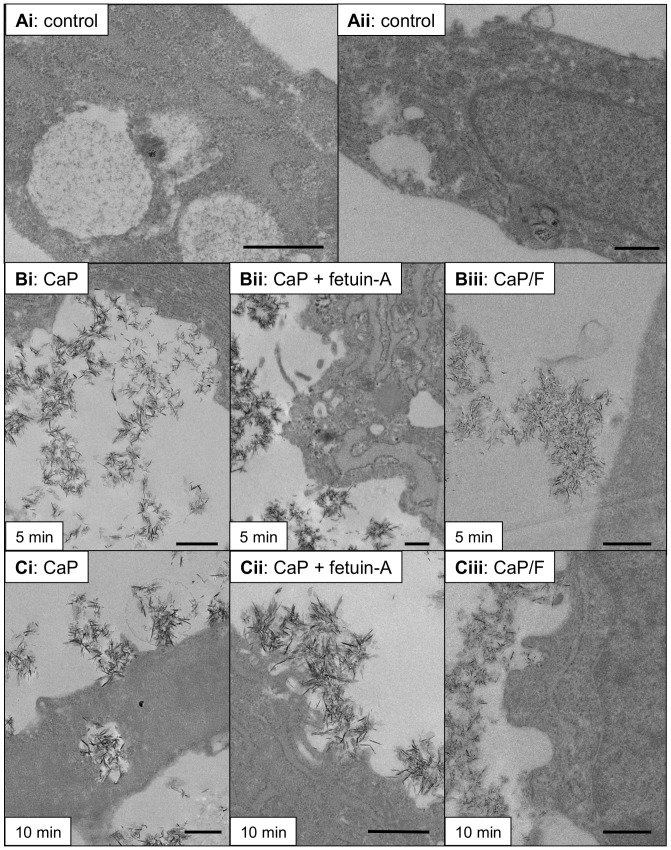
TEM images of CaP particle/VSMC interactions in the presence of fetuin-A.TEM images show ultrastructural features observed after treatment of VSMCs with CaP particles (12.5 µg/mL) ± fetuin-A (1 µM) or with CaP/F (12.5 µg/mL). Control images from cells exposed to physiological buffer without CaP particles are shown in Ai and Aii. After 5 minutes of particle exposure (middle panel), CaP/plasma membrane interactions were observed (Bi) but these interactions were not commonly observed in the presence of fetuin-A (Bii) or with CaP/F particles (Biii). After 10 minutes (lower panel, Ci–iii), CaP particle interactions with the plasma membrane were detected for each condition. Bar = 500 nm.